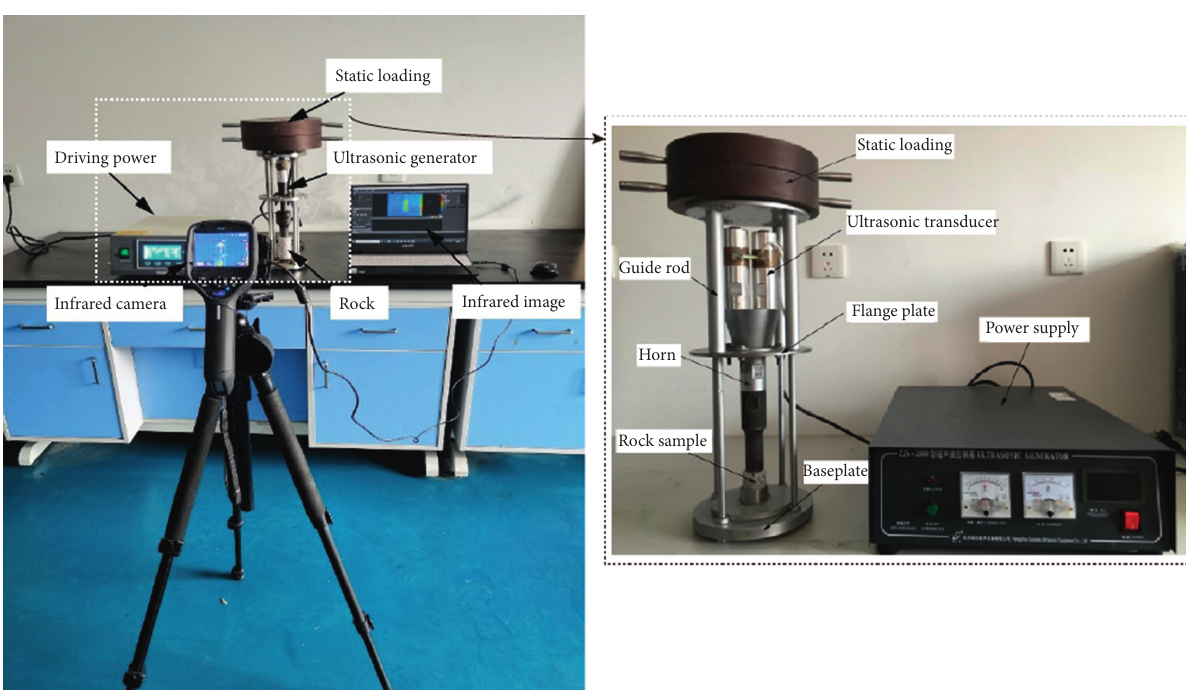
Figure 5: Physical map of ultrasonic vibration